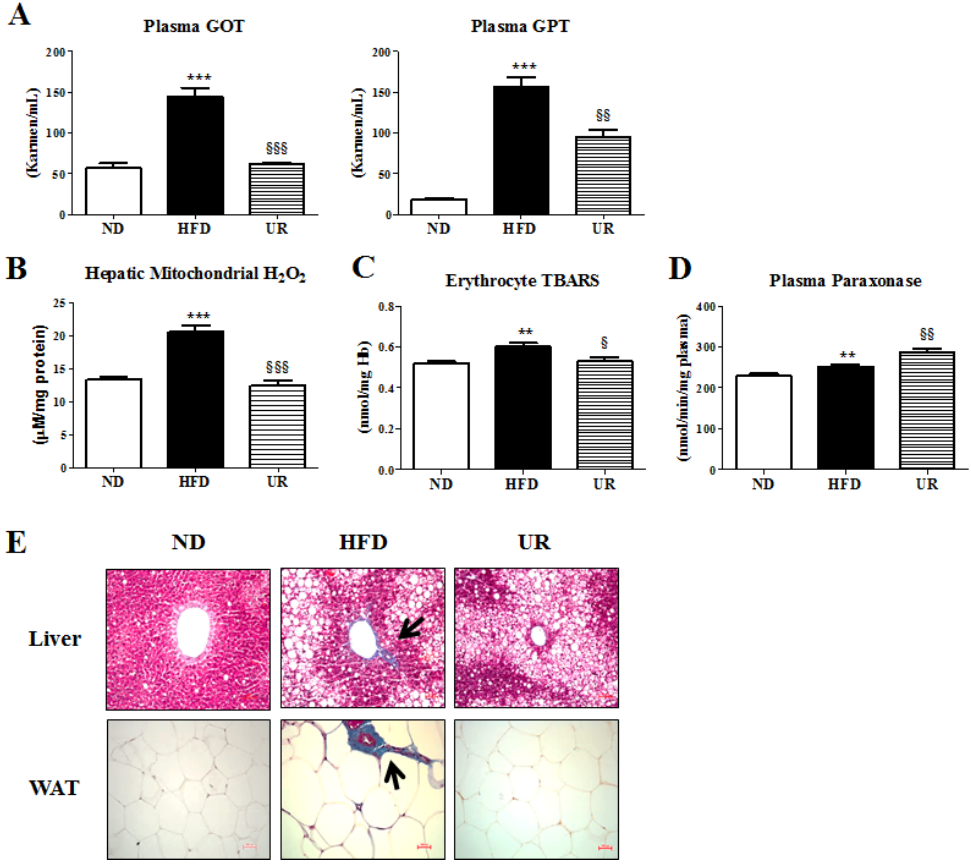
Figure 3. Effect of ursolic acid (UR) treatment on: plasma GOT and GPT ( A ); hepatic mitochondrial H 2 O 2 ( B ); erythrocyte thiobarbituric acid reactive substance (TBARS) ( C ); plasma paraoxonase (PON) ( D ); and Masson’s trichrome staining (magnification ×200) ( E ) in C57BL/6J mice fed a high-fat diet (HFD). Data are shown as means ± SEM. Normal diet (ND; AIN-76) vs. HFD; * p < 0.05, ** p < 0.01, *** p < 0.001. HFD vs. UR (HFD + 0.05% UR); § p < 0.05, §§ p < 0.01, §§§ p < 0.001. GOT, glutamic oxaloacetic